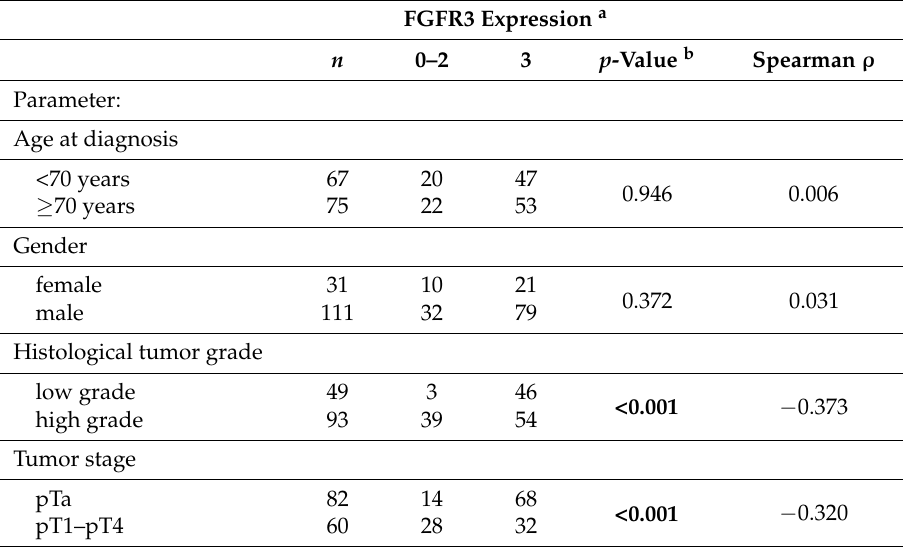
Table 1. Clinico-pathological parameters in correlation to FGFR3 protein expression.